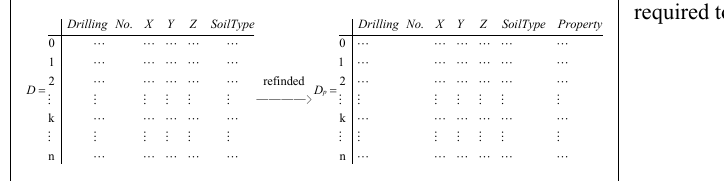
The target cross-section includes two parts: one is the cutter head surface, and the other is the surrounding strata. The location of the section is dependent on the mileage of the tunnelling route. The section’s size is adjusted to the diameter of tunnelling. During the excavation, these parameters are predesigned in the construction scheme and can be provided as input arguments for model generation. This study proposes Figure 2 . Illustration of data processing Algorithm 2 to show the procedures of parametric modelling. As the created cross-section model is a boundary representation (Brep) object, it still needs to be processed with grid division for transformation into a mesh model. An illustration of the cross-section modelling and grid division is presented in Figure 4 . Then, unduplicated nodes are retrieved from the mesh model, and their coordinates (as V ) are regarded as the estimating objects for maximum likelihood estimations. They are also